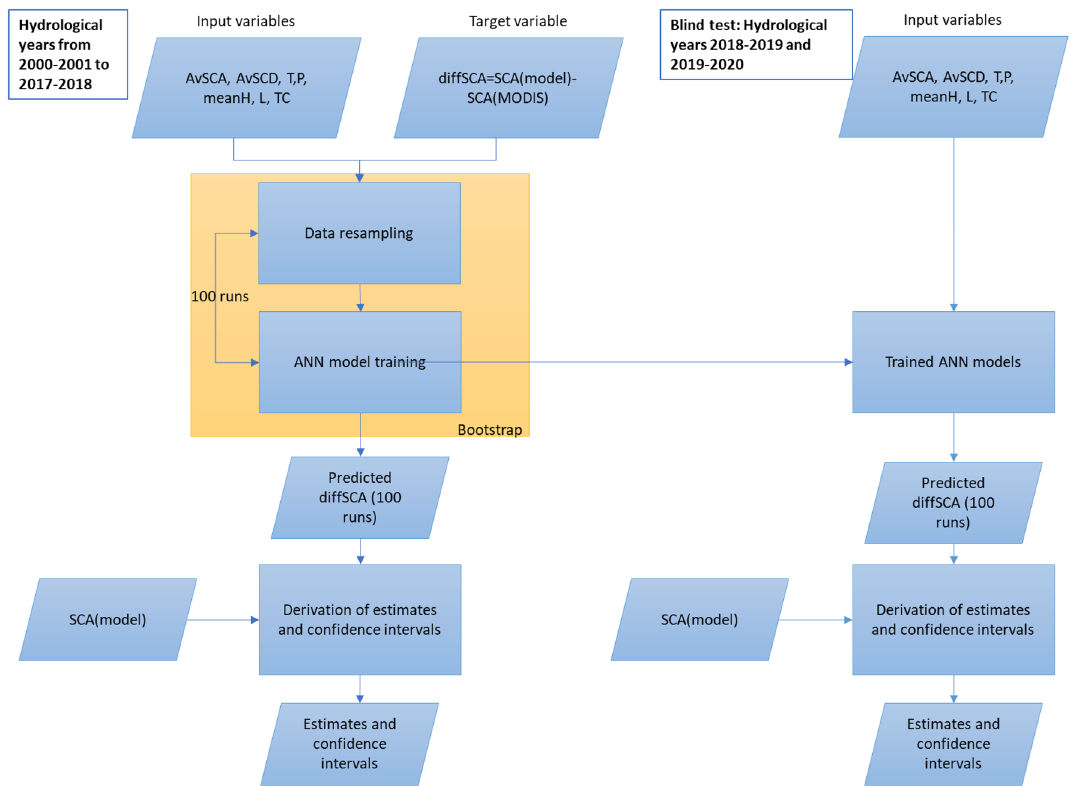
Figure 6. Flowchart of the overall procedure. It is shown the case where the target variable is the yearly SCA. The same applies for the other considered target variables that is SCD, SON SCA, DJF SCA, MAM SCA, JJA